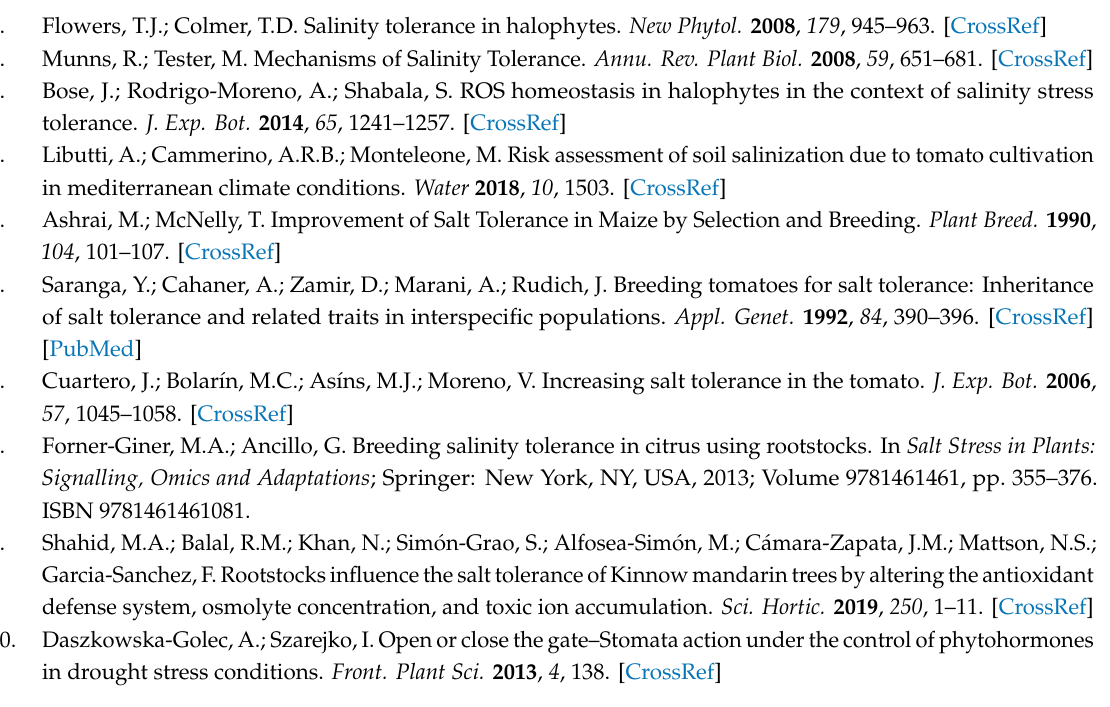
Figure S1: Acummulated explained variance of each principal component and eigenvalues for the principal component analysis of morphological variables. Figure S2: Example of Control, Tolerant and Sensitive phenotype of D. lotus L. plants after 60 days of salt stress. Figure S3: Acummulated explained variance of each principal component and eigenvalues for the principal component analysis of physiological and morphological variables. Figure S4: Venn diagram of the orthogonal analysis for identification of leaf-specific di ff erential expressed genes between tolerant and sensitive plants. Figure S5: Venn diagram of the orthogonal analysis for identification of root specific di ff erential expressed genes between tolerant and sensitive